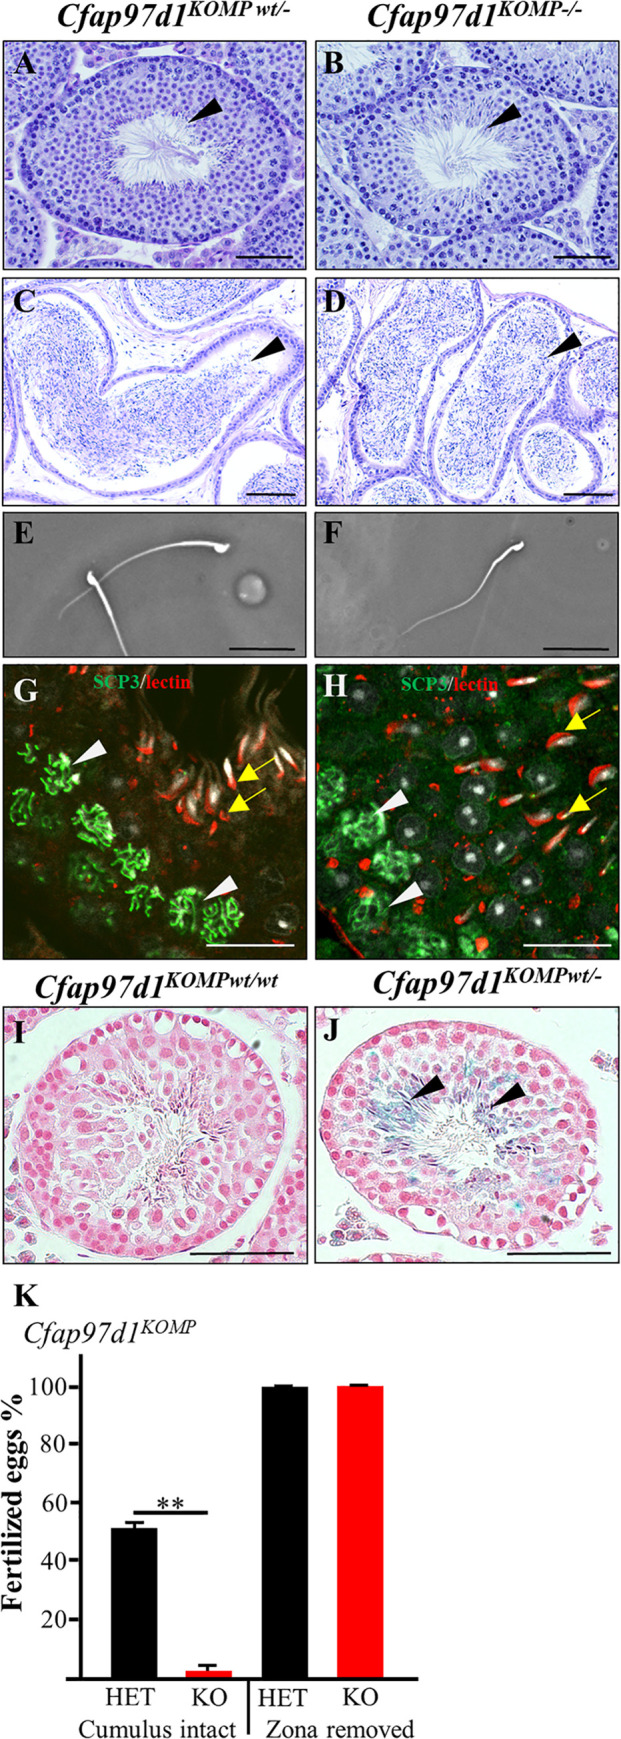
Morphology of testes and spermatozoa in Cfap97d1 knockout, and Cfap97d1 expression localization.(A-D) PAS staining of testicular sections (stage VII-VIII) from Cfap97d1KOMPwt/-
(A), Cfap97d1KOMP-/- mice 9 wks of age (B) and epididymis of control Cfap97d1KOMPwt/-
(C), Cfap97d1KOMP-/- mice 8 wks of age (D) illustrates sperm presence in the tubules (arrows). Spermatozoa collected from cauda epididymis of control Cfap97d1KOMPwt/-
(E) and Cfap97d1KOMP-/-
(F) mice do not show gross morphological changes. (G, H) Immunostainings with meiotic marker SYCP3 (green, white arrowheads) and lectin labeling acrosome (red, yellow arrows) are comparable between Cfap97d1KOMPwt/-
(G) and Cfap97d1KOMP-/-
(H) mice, nuclear staining by Hoechst (grey). (I, J) β-Galactosidase staining of wild-type (I) and Cfap97d1KOMPwt/- testes where staining co-localizes with the elongating spermatids (J, black arrows). (K) Fertilization of intact oocytes by Cfap97d1KOMP-/- sperm is significantly reduced, whereas fertilization of zona-free oocytes was comparable to control (oocytes from three mice per genotype were used for experiment). Scale bar A-F 50 μm; G-J 100 μm. Error bar indicates unbiased standard deviation of fertilization rate per male. **P < 0.01, Student’s t-test; ±SD.